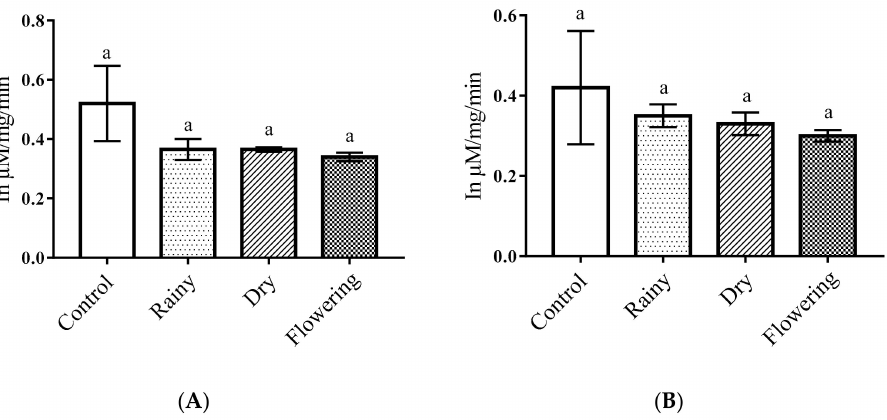
Figure 5. Biochemical changes in proteases of Ae . aegypti and Ae . albopictus larvae. Changes in protease levels between Ae . aegypti ( A ) and Ae . albopictus ( B ) larvae treated and not treated with the essential oils of Lippia grata . Different lowercase letters in the bar denote significant difference ( p < 0.05). Bars represent standard deviations ( n = 3). Values estimated by one-way ANOVA followed by the Tukey test. Control, untreated